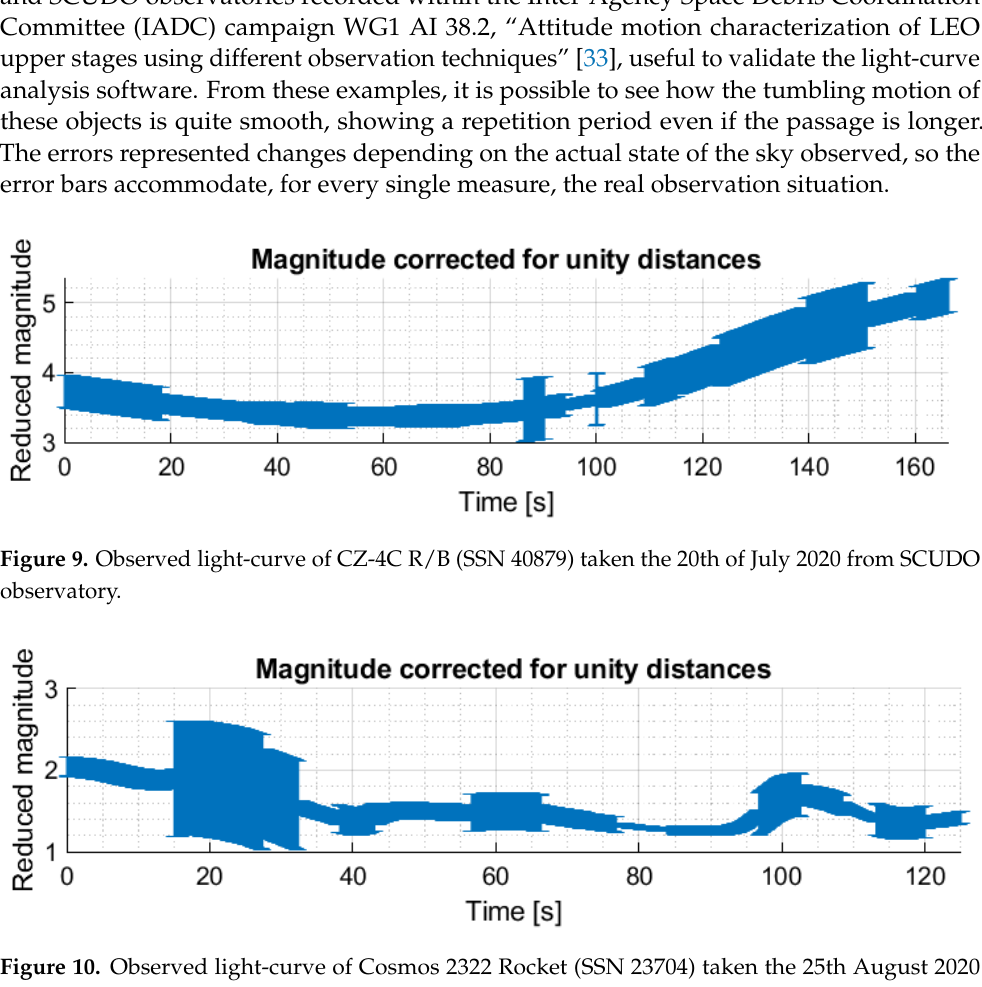
Figure 11. Observed light-curve of Cosmos 2297 Rocket (SSN 23405) taken the 28th of August 2020 from SCUDO observatory. Many tests were needed to calibrate the software parameters to obtain a correct cal- culation of the magnitude of the stars and the object and also to correctly follow the objects in the video frames. Once the software was validated, a simultaneous observation test was pursued. Figures 12 and 13 show an example of light-curves obtained during a bi-static observation taken from RESDOS and SCUDO observatories. The object under considera- tion is the satellite ATLAS 2AS CENTAUR (SSN 28096) during its passage above Italy, which occurred on the 30/10/2020 at 19:29:00 UTC. It is possible to notice how, even if the main behavior is similar, some small differences are representative of different attitudes of reflective faces with respect to the two observatories. These differences are of para- mount importance in the process of light-curve inversion that is discussed later.